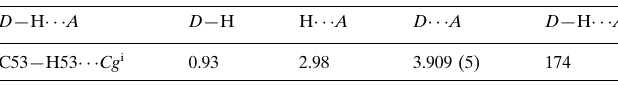
Hydrogen-bond geometry (A˚ , (cid:1)